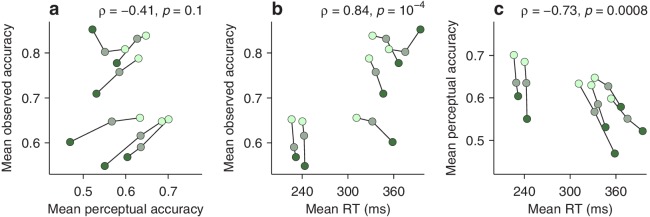
Dissociation between perceptual capacity and overall task performance as seen with the accelerated race-to-threshold model.Results were obtained in the exact same way as those in Figure 5, except that they were based on simulated trials. The model data were generated using the best-fitting model parameters for each individual participant. Same format as in Figure 5.